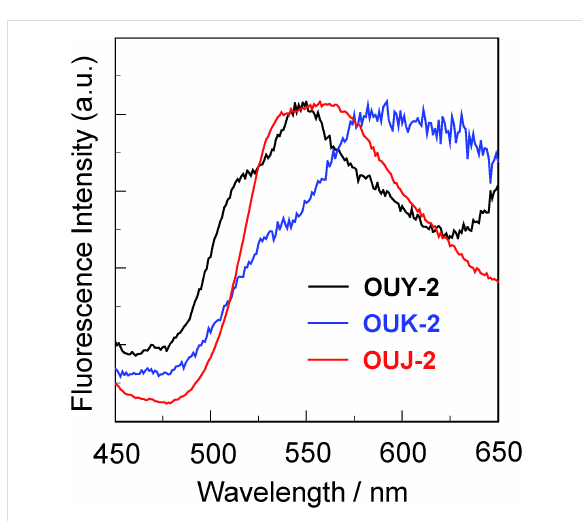
Figure 4: Fluorescence spectra of OUY-2 ( λ ex = 370 nm), OUK-2 ( λ ex = 370 nm) and OUJ-2 ( λ ex = 380 nm) in the solid state.